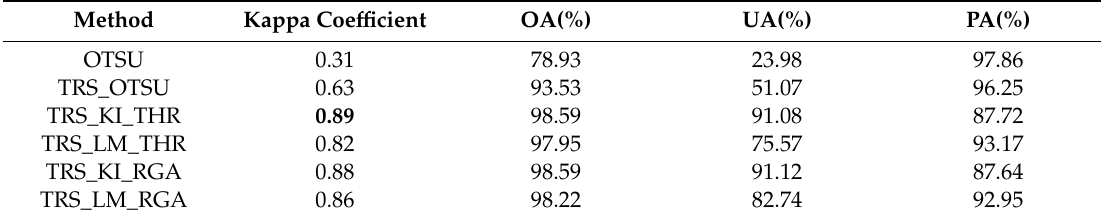
Table 5. Comparison of the accuracy using di ff erent methods for VH